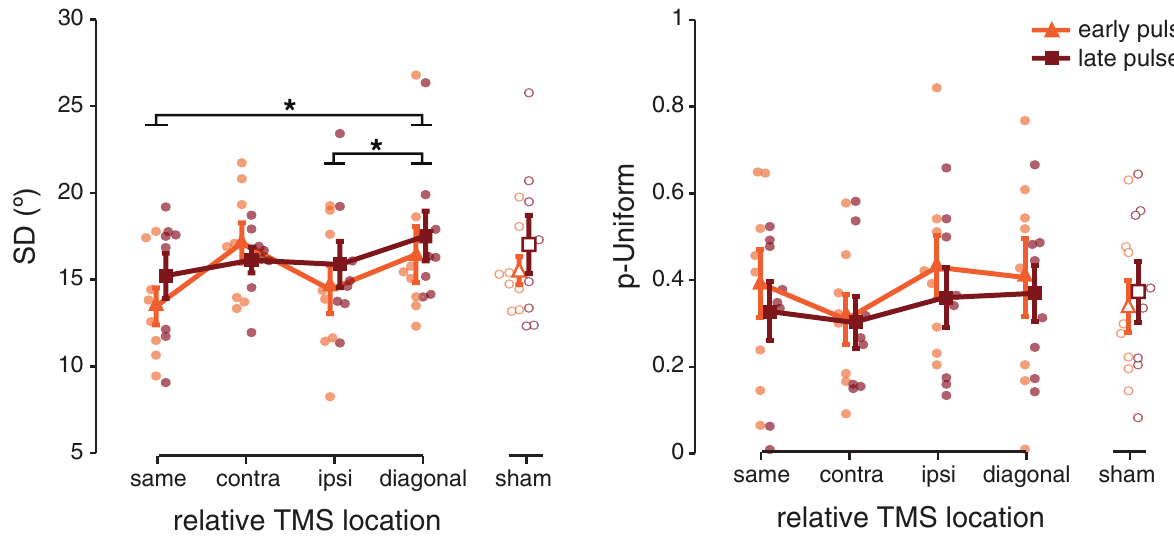
Fig 3. Model fits of TMS data. (A) Memory precisionis represented by the mixed-model SD , with a smaller SD indicatingmore precision. Memory was most precisewhen the location of the target item overlapped with the location at which TMS was applied,or was ipsilateral to it, comparedto pulses diagonalto the cued item. (B) When pulses were deliveredearly during the delay, participants were more likely to guess comparedto pulses deliveredlate, irrespectiveof their location relative to TMS. Parameter estimates were obtained by finding the best-fitting mixture-model (centered on 0˚) for the frequency distribution of each condition, using a bin width of 12˚ (mean R 2 = 0.894 ± 0.029). Bin size was chosen to maximize the mean R 2 values across experimental conditions. Transparent dots indicate individual participantdata, error bars depict ± 1